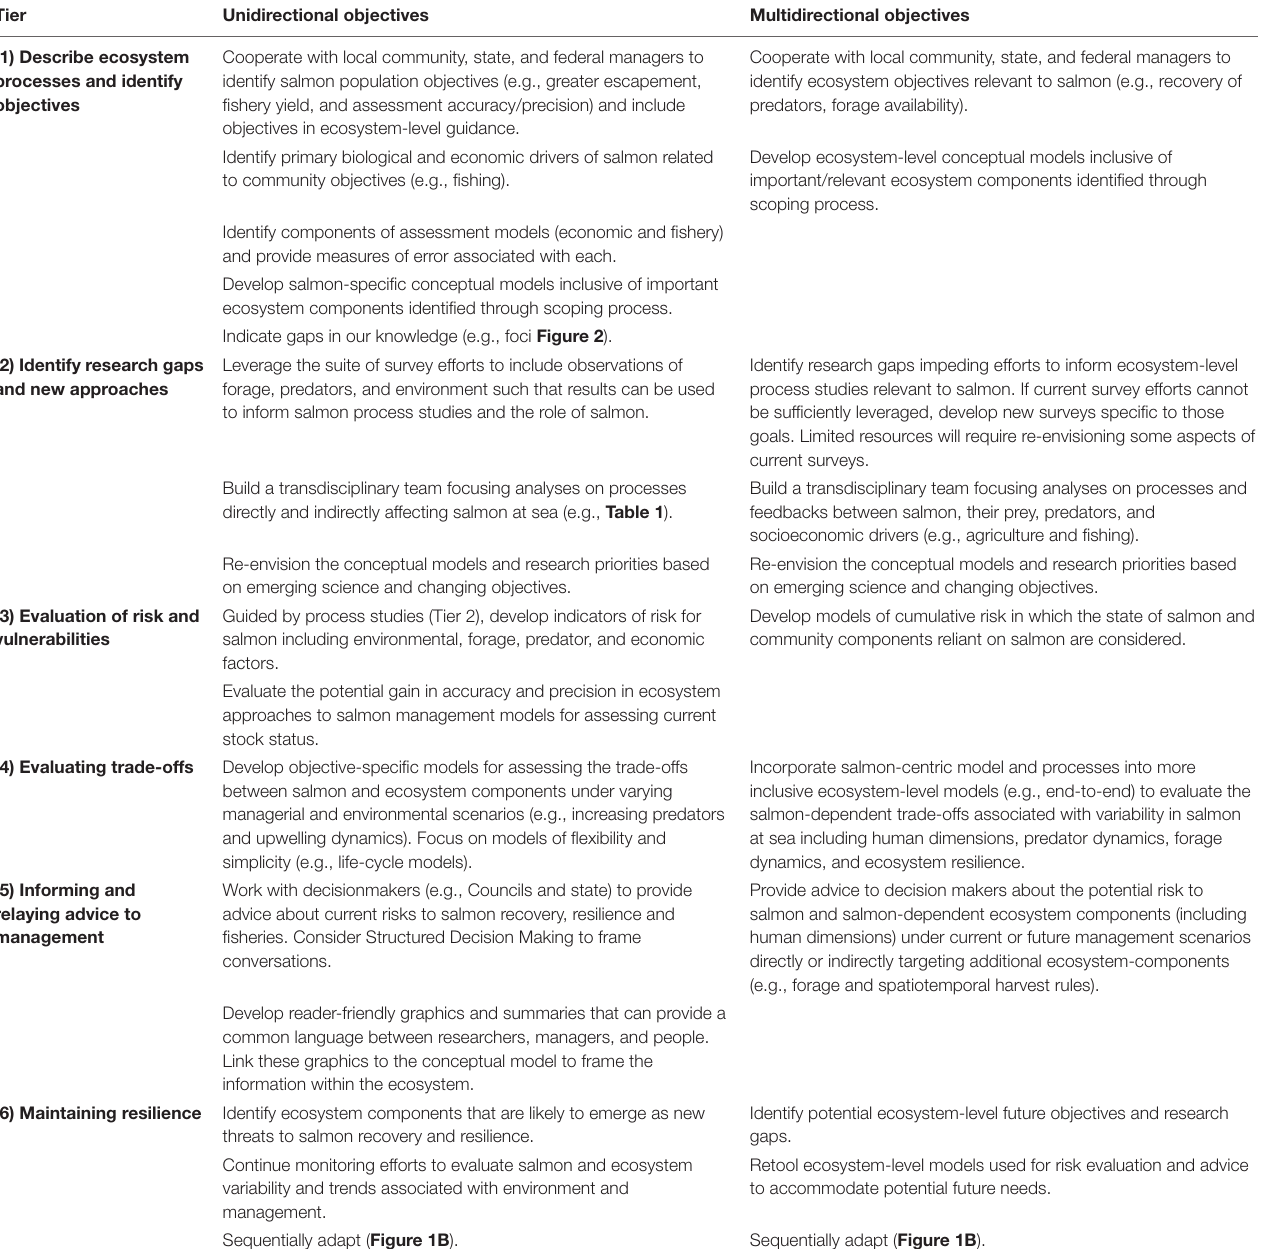
TABLE 2 | We summarize simple, unidirectional (i.e., effects of ecosystem components on salmon) and complex, multidirectional (i.e., interactions between salmon and ecosystem components) objectives for achieving EBM. Tier Unidirectional objectives Multidirectional